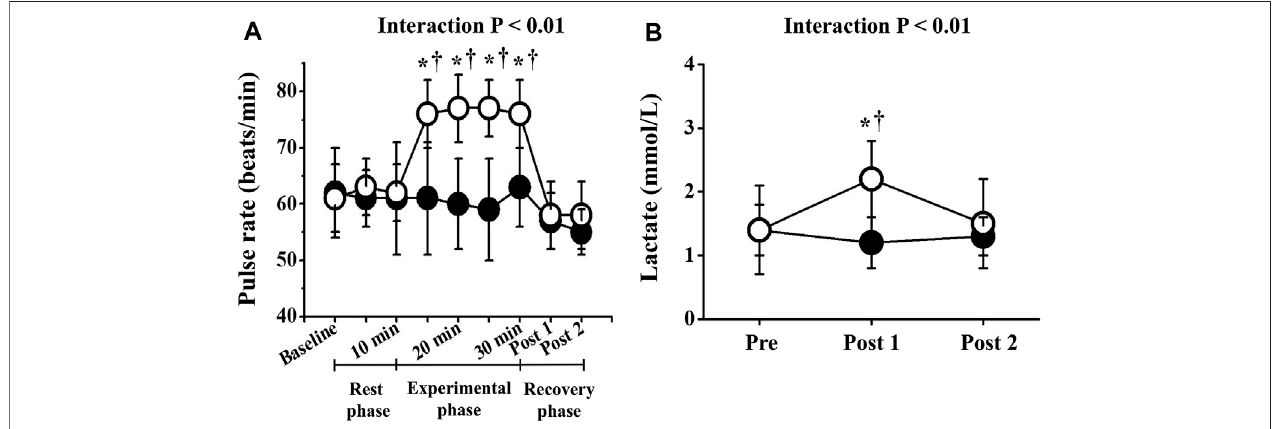
(cid:129) ), control resting trial; open circles ( ○ ), electrical stimulation trial. Other